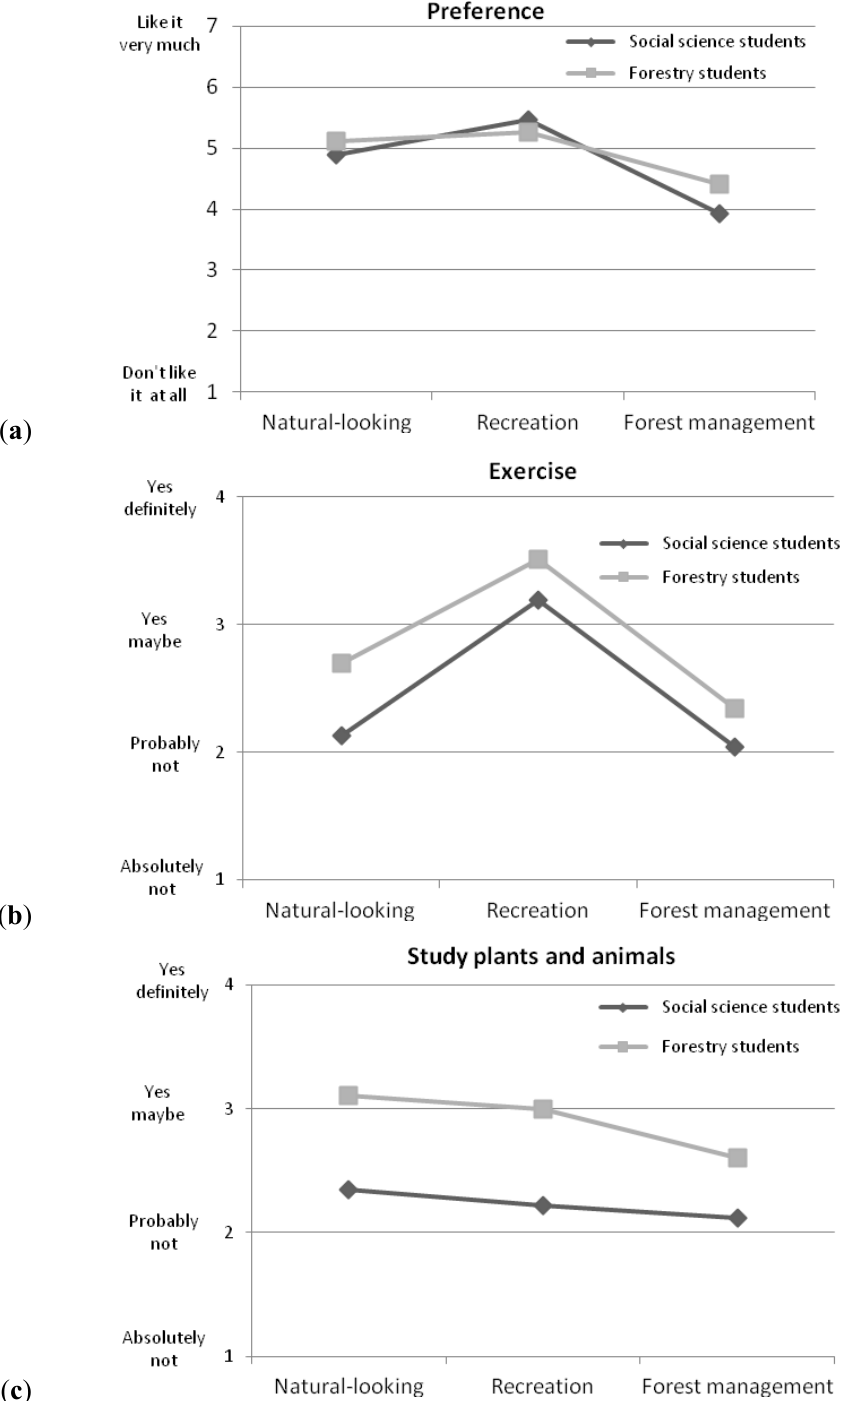
Figure 2. Two-way interactions between type of human intervention and group: ( a ) Preference as a function of human intervention and group, ( b ) intention to exercise as a function of human intervention and group, ( c ) intention to study plants and animals as a function of human intervention and